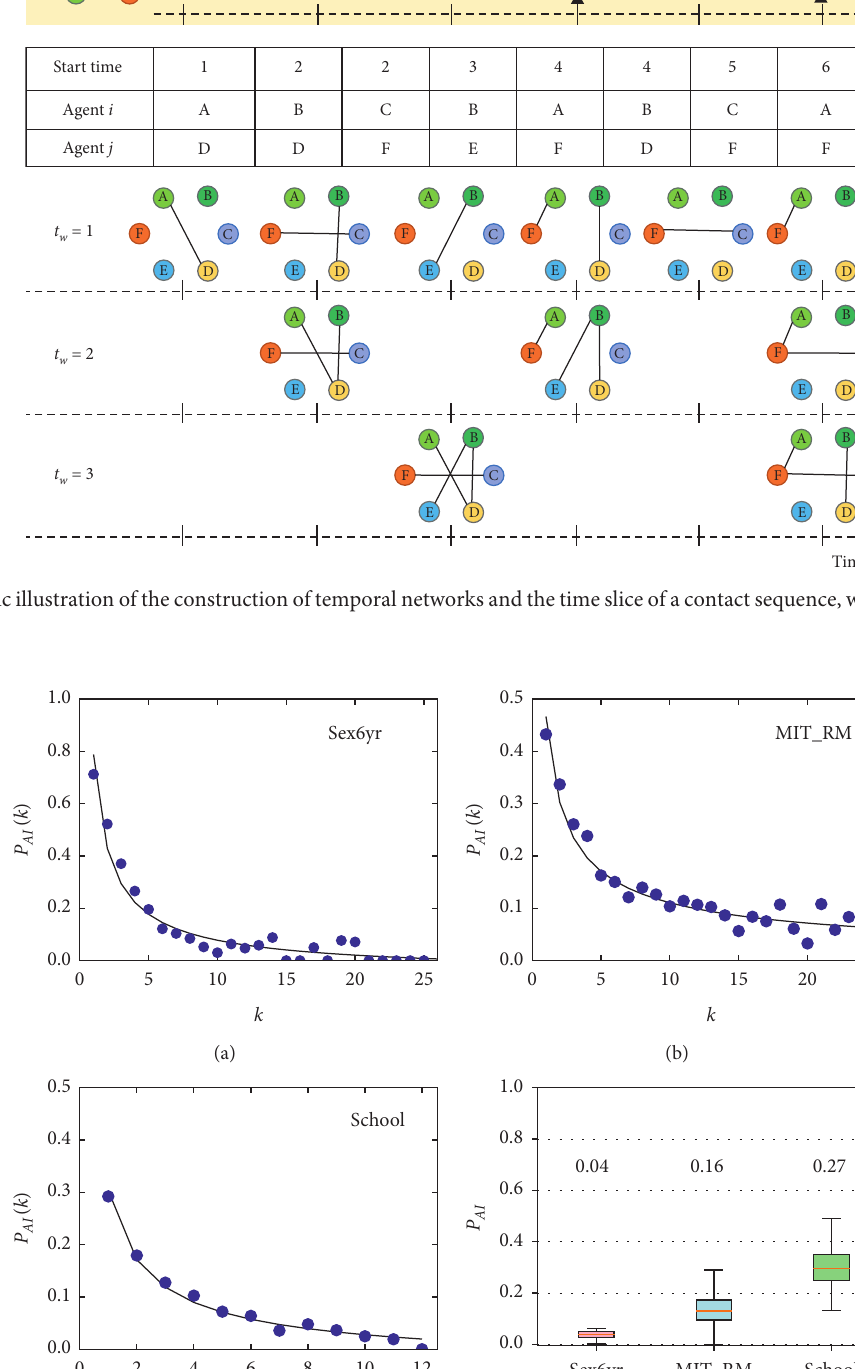
( k ) � 0 . 78 k − 0 . 84 (Sex6yr), (b) P ( k ) � 0 . 45 k − 0 . 56 (MIT_RM), and AI AI with 95% confidence intervals in the three empirical datasets. The average firing rates IA